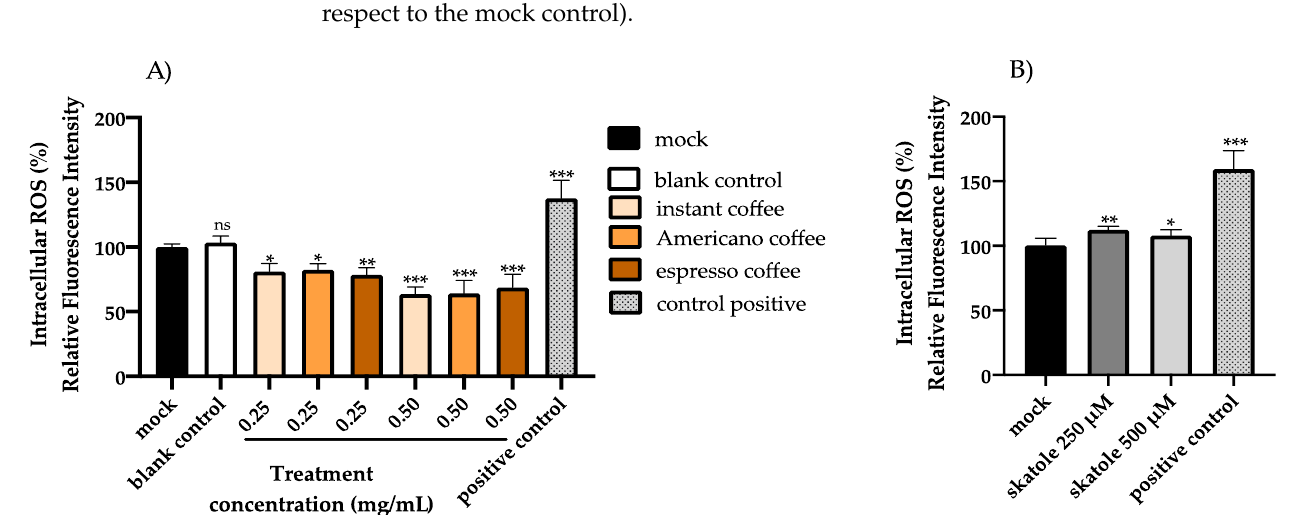
Figure 2. Evaluation of intracellular ROS level in HT-29 cells. The effect on the generation of intracellular ROS levels after treatment with a blank control (resulting from in vitro digestion) and the different types of coffee extract (instant, Americano, and espresso) at 0.250 and 0.500 mg/mL was evaluated using the H 2 DCF-DA assay after 24 h of treatment, and compared with the mock control (untreated cells) ( A ). The effect of skatole treatment ( B ) on the production of intracellular ROS was estimated by fluorometric assay after 24 h at the concentrations of 250 and 500 µM and compared to the control cells (treated with DMSO only). Cells treated only with H 2 O 2 were used as a positive control. The graphs represent the mean and SD of three separate experiments. * p -value ≤ 0.05, ** p -value ≤ 0.01 and *** p -value ≤ 0.001 compared to the control group (calculated as fold-change relative to control cells, arbitrarily set at 100%).